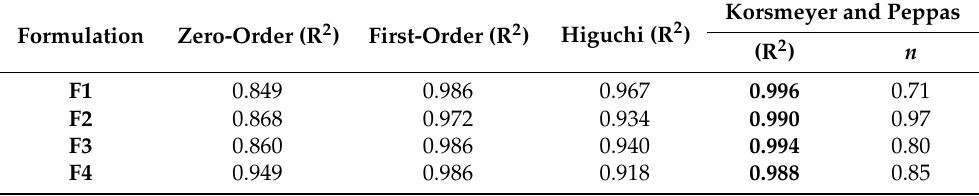
Table 4. Nizatidine release kinetics from floating tablets.